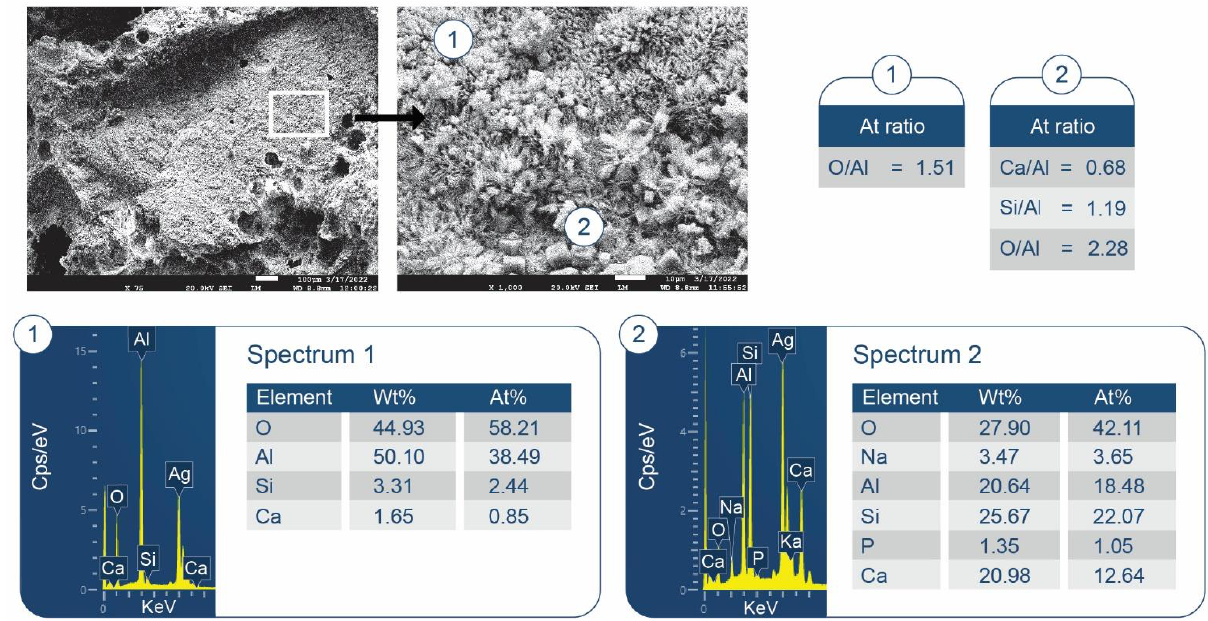
Figure 38. Photomicrographs of 250 °C-autoclaved 87/13 ratio composite at the location of disinte- grated HSA.